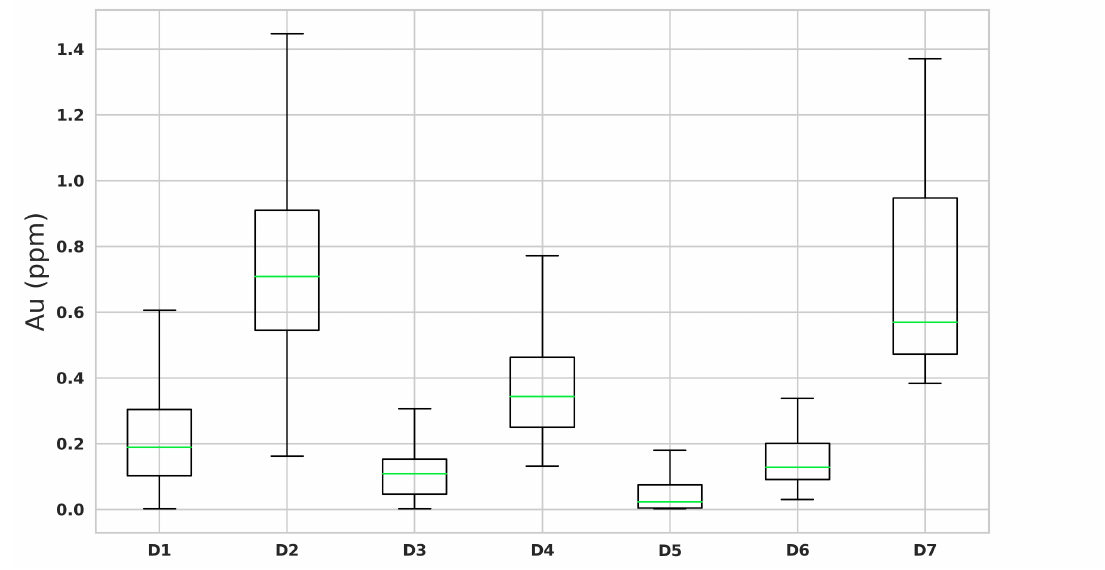
Figure 8. Boxplot by estimation domain.